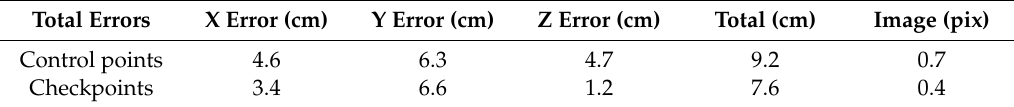
Table 1. RMSE at control points and checkpoints.